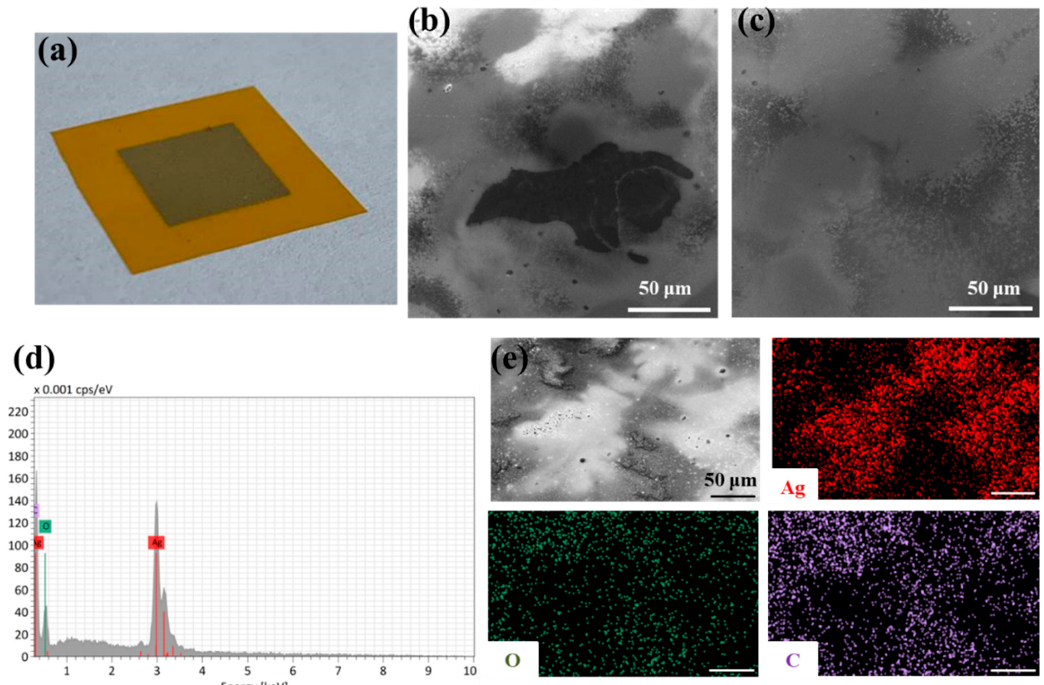
Figure 13. ( a ) Image of the printed silver feature on a bare PI substrate before annealing, and SEM micrographs of the thin-film surface ( b ) before and ( c ) after IPL annealing; ( d ) EDX spectra and ( e ) elemental mapping of the as-produced conductive squares. Imaged at 1000 × magnification; all insert scale bars are 50 µ